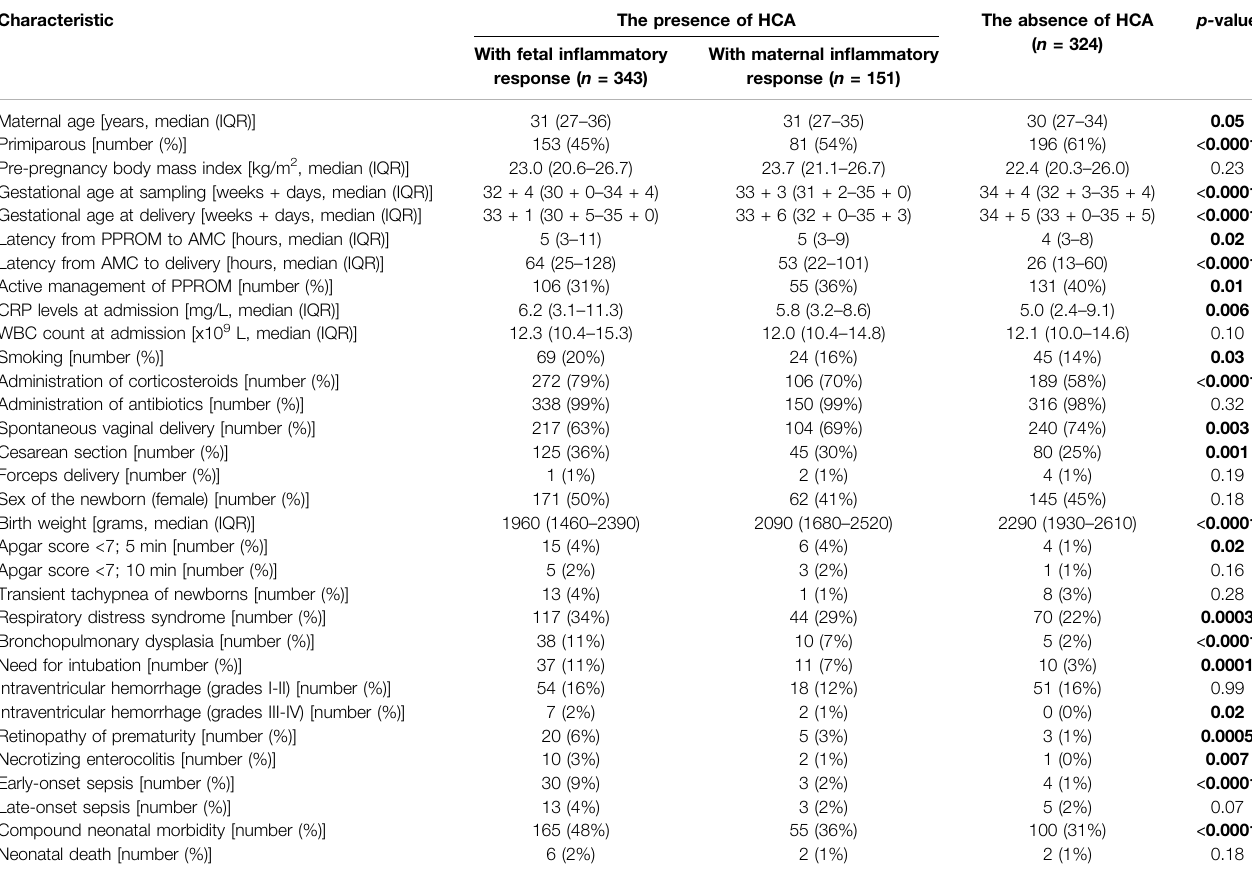
TABLE 1 | Maternal and clinical characteristics of women with preterm prelabor rupture of membranes and short-term neonatal outcomes with respect to the presence of HCA with fetal and maternal in fl ammatory responses and the absence of HCA. Characteristic The presence of HCA The absence of HCA ( n = 324) With fetal in fl ammatory response ( n =